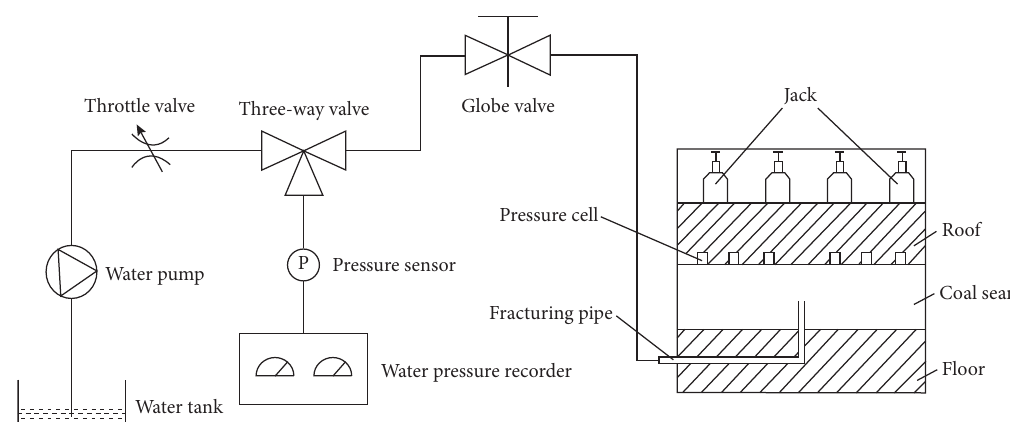
Figure 1: Experimental system for hydraulic